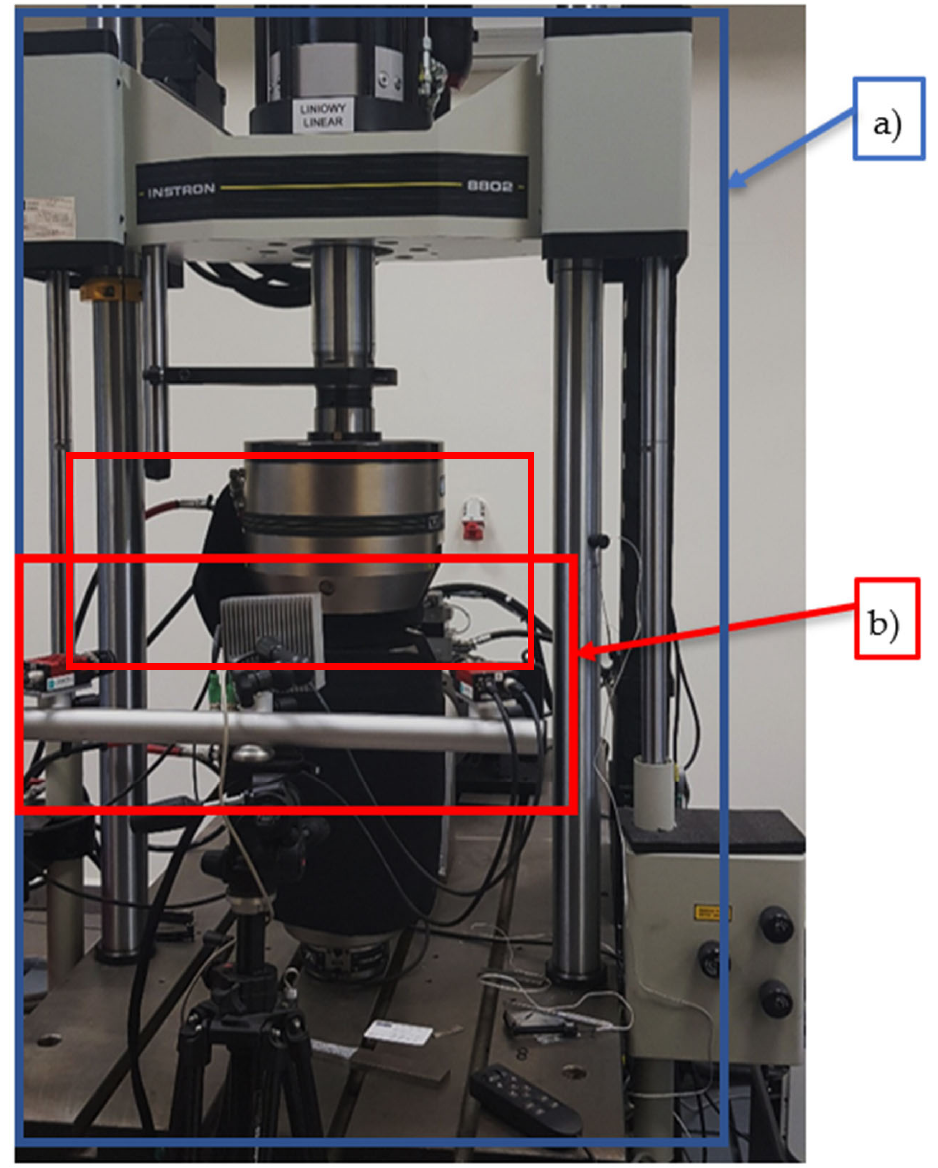
Figure 5. Servo ‐ hydraulic pulsator for tensile tests Instron 8802 ( a ) with digital image correlation system DIC ( b ).